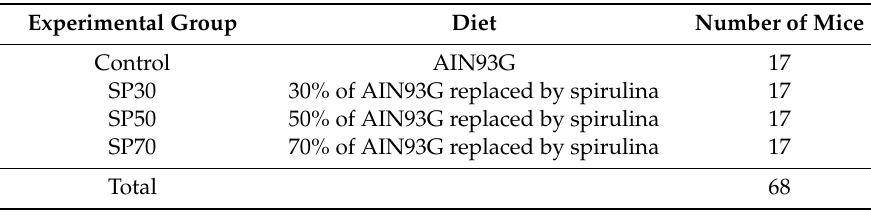
Table 1. Experimental design of the study.